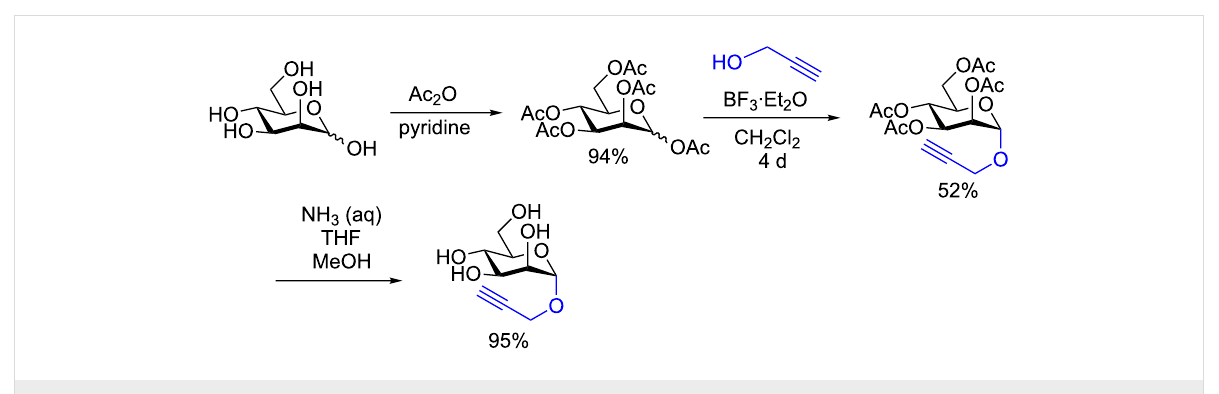
Figure 3: Protecting-group-free glycosyl donors and acceptors used in the Au(III)-catalyzed glycosylation.